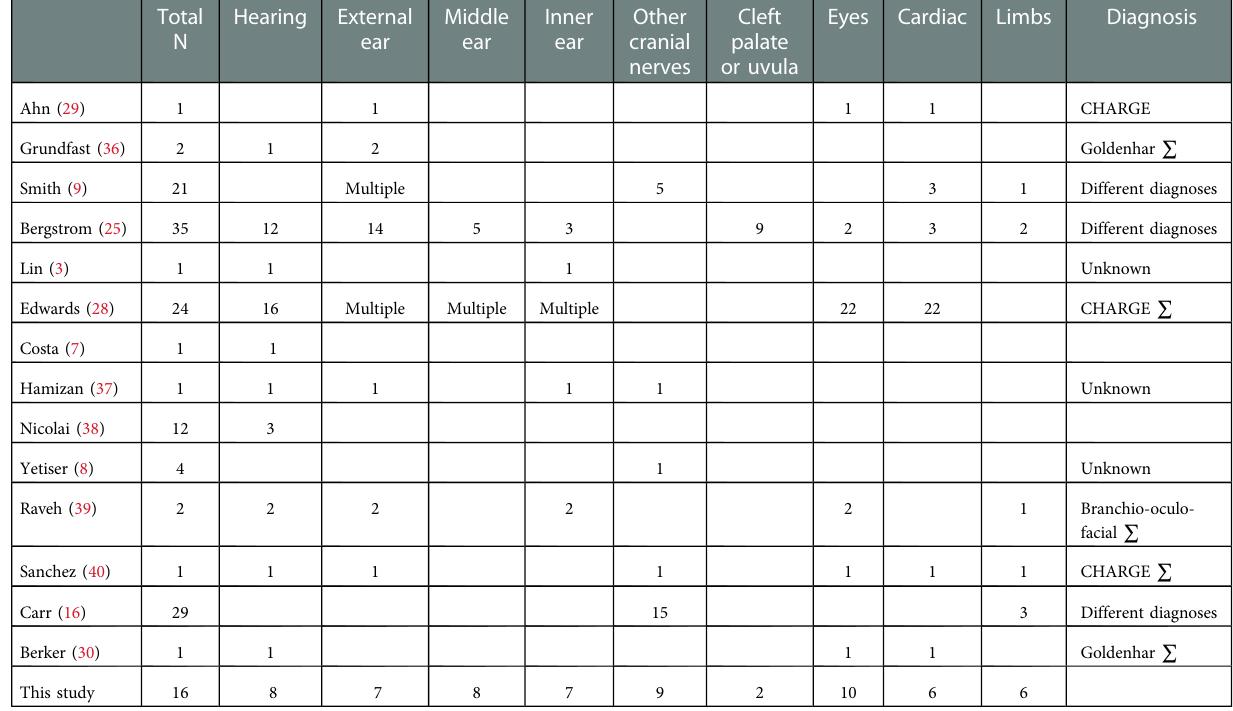
TABLE 1 Results literature